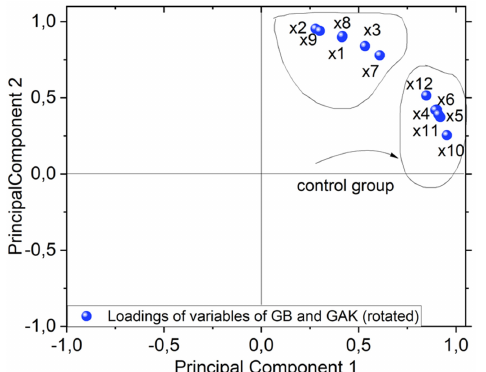
Figure 8. PCA biplot of both sample giant bamboo GB and G. angustifolia Kunt GAK showing clustering (untreated or control group pointed out with black arrow and treated samples). 4. Discussion The results of this study on giant bamboo (GB) and G. angustifolia Kunt (GAK) with different length samples and treated with the F. incarnatum-equiseti strain MF18MH45591 for 21 d showed noticeable variations in the intensities of the ATR-FTIR spectra in the region of interest for lignin components. Many of the characteristic lignocellulose bands overlap with cellulose and hemicelluloses at the range of1369 cm − 1 to 1883 cm − 1 . The peaks at 1464 cm − 1 to 1530 cm − 1 for lignin components, which were in the ROI, had ap- proximately 50% less intensity compared to the untreated samples for both the GB and